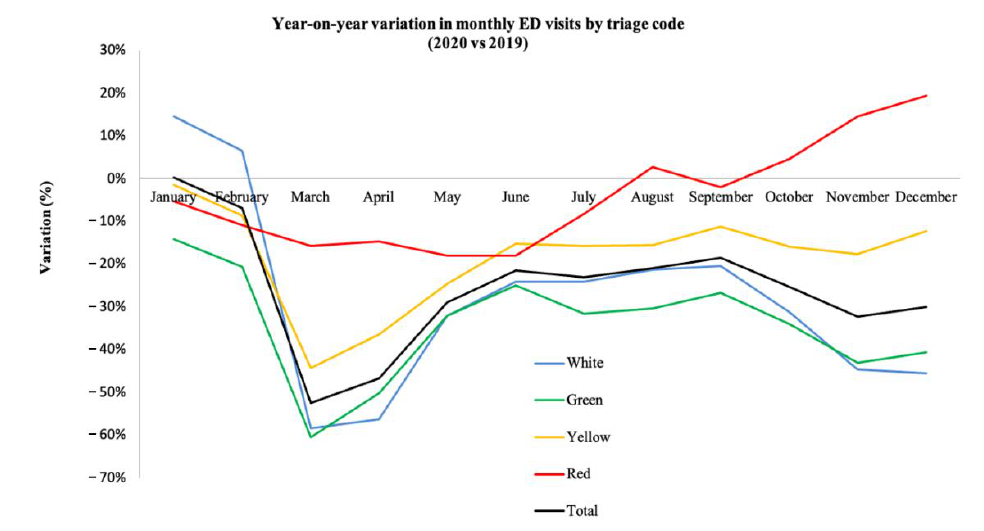
Figure 2. Year-on-year change (%) in the number of monthly emergency department (ED) visits 2019–2020, by triage code and overall. Orange triage codes introduced in 2020 were merged with yellow codes for consistency with the rest of the study period.